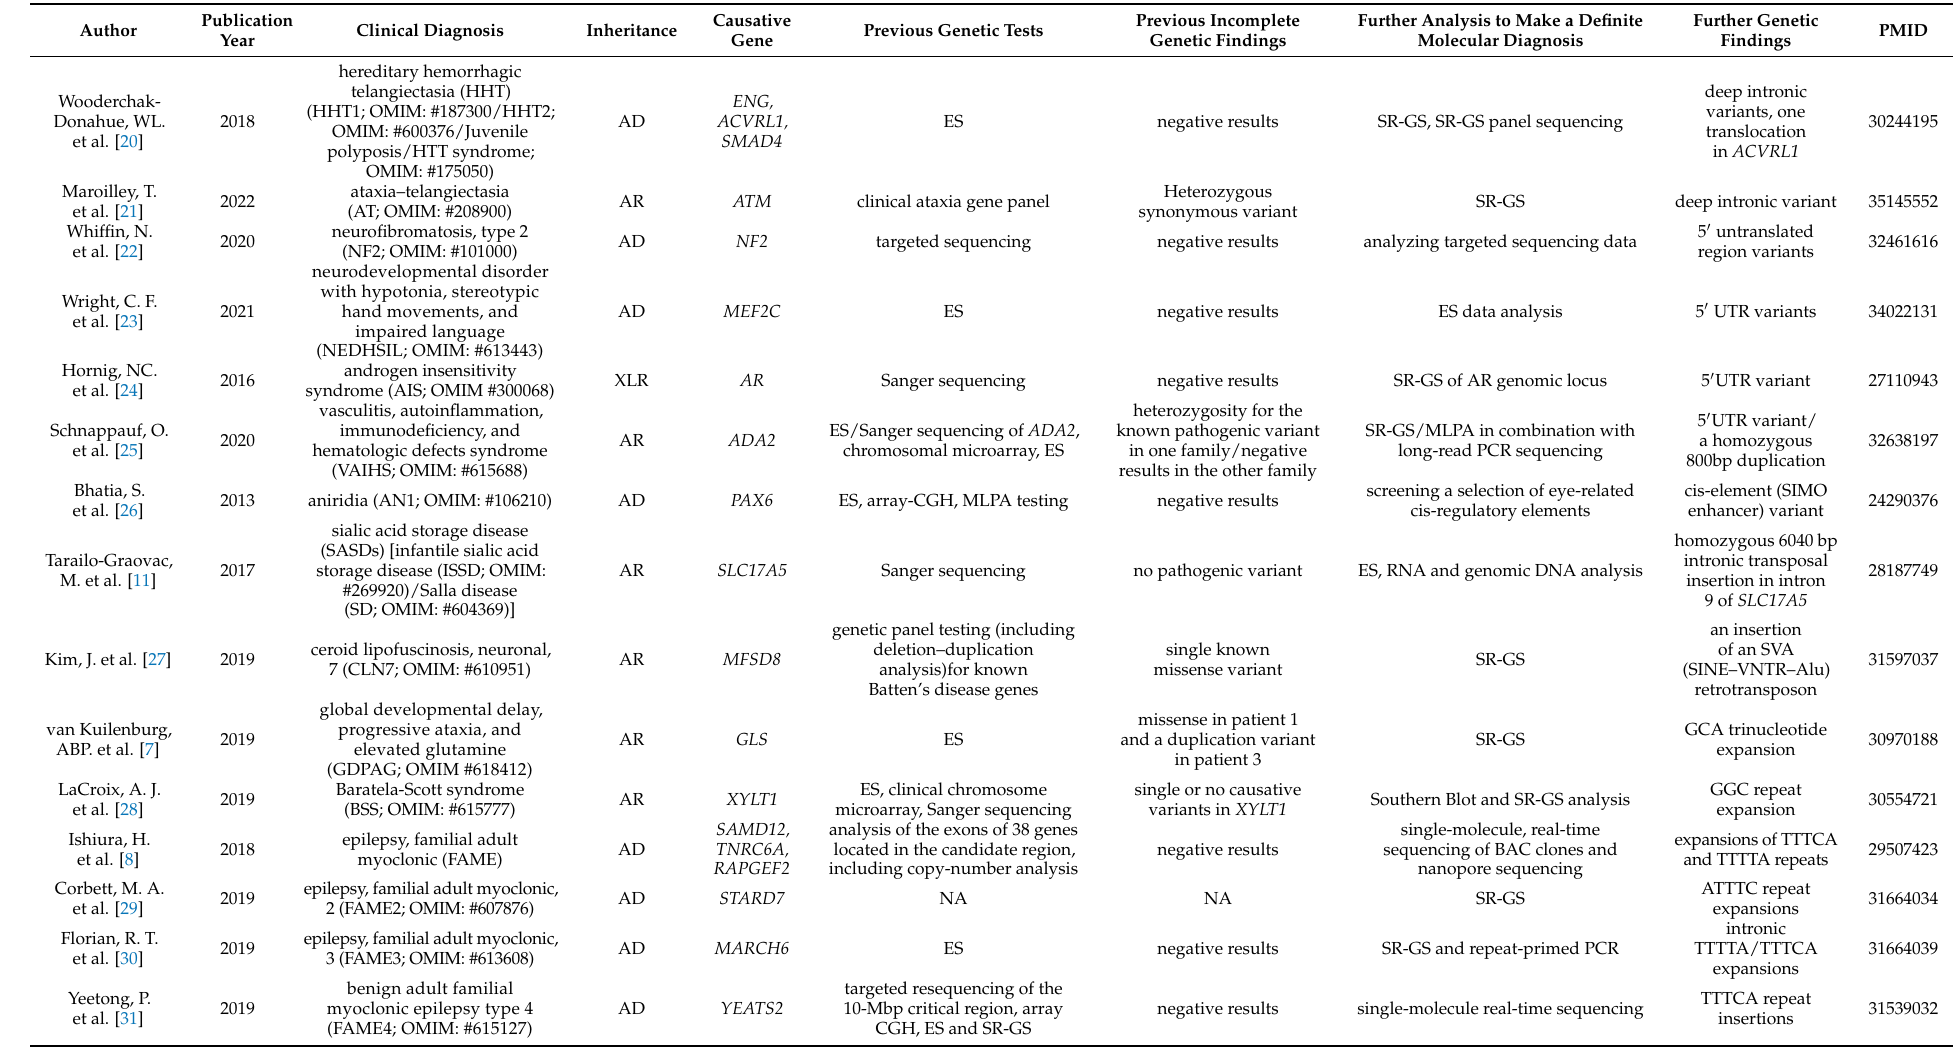
Table 1. The examples of clinical diagnoses leading to the elucidation of the complex genetic